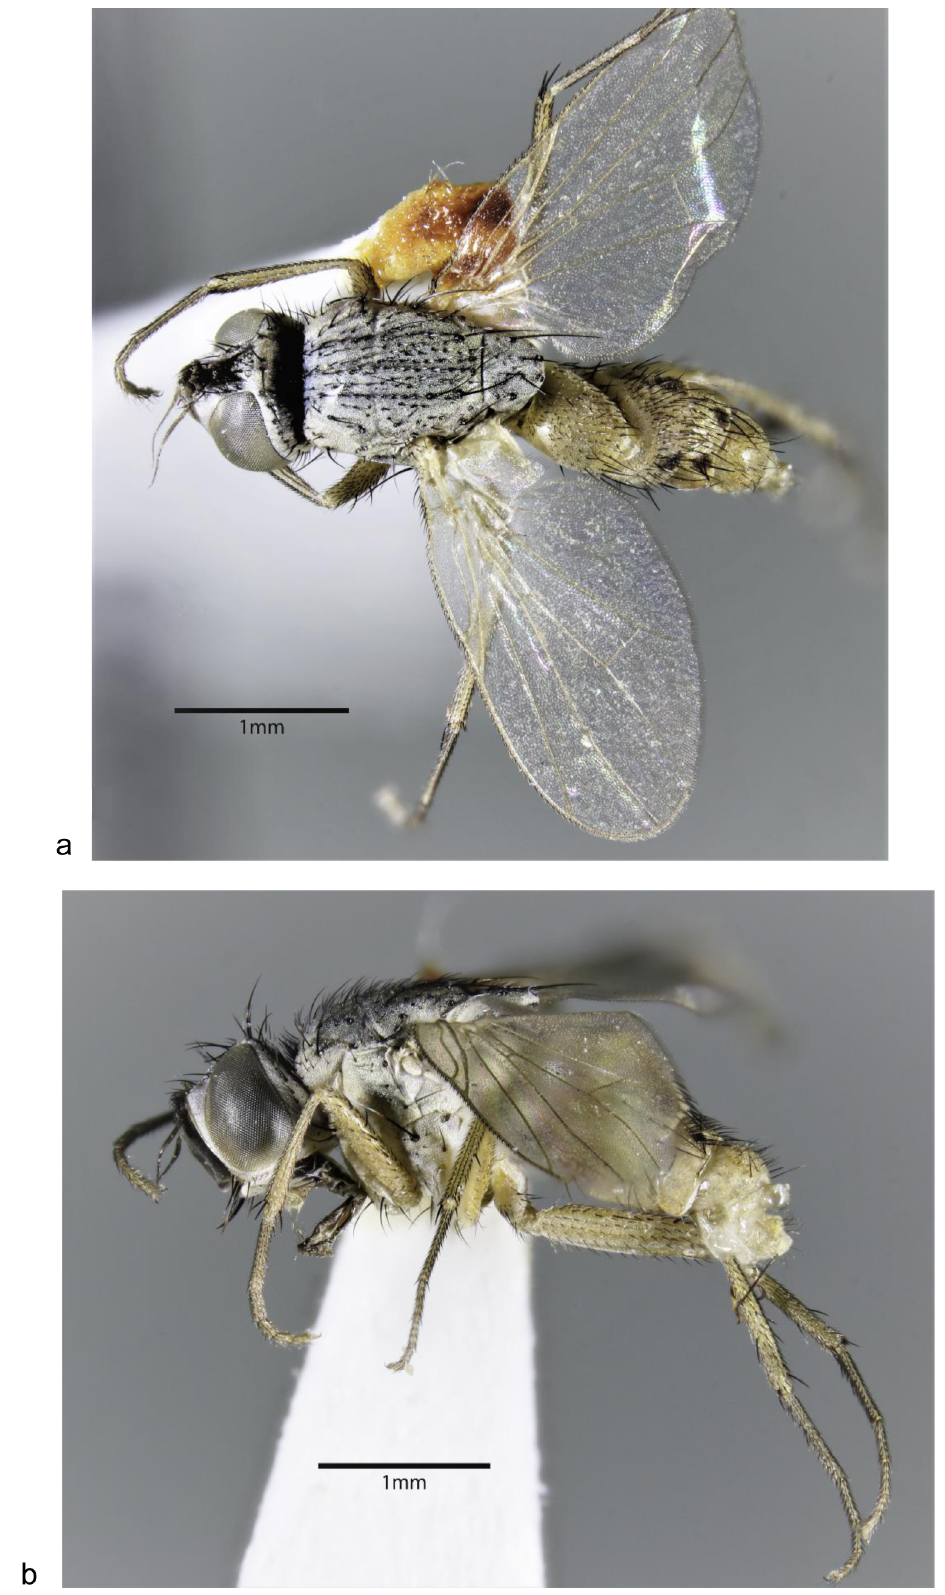
Fig. 5. Atherigona zongoi sp. nov., holotype, ♂ (NMWC), habitus. a . Lateral view. b . Dorsal